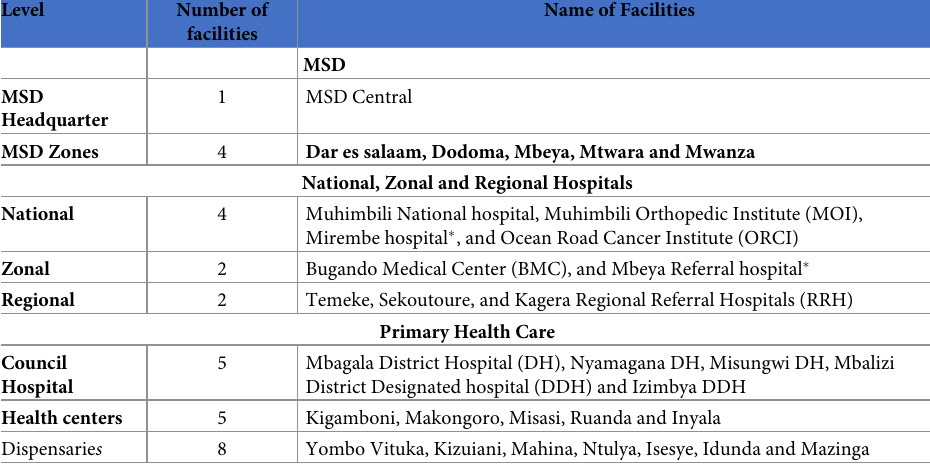
Table 1. Health facilities visited for supply chain